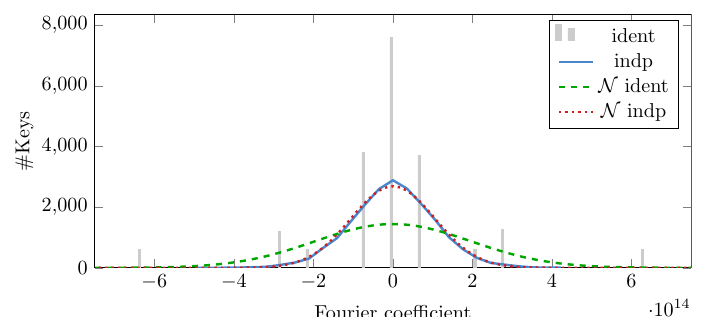
ident ident N indp N